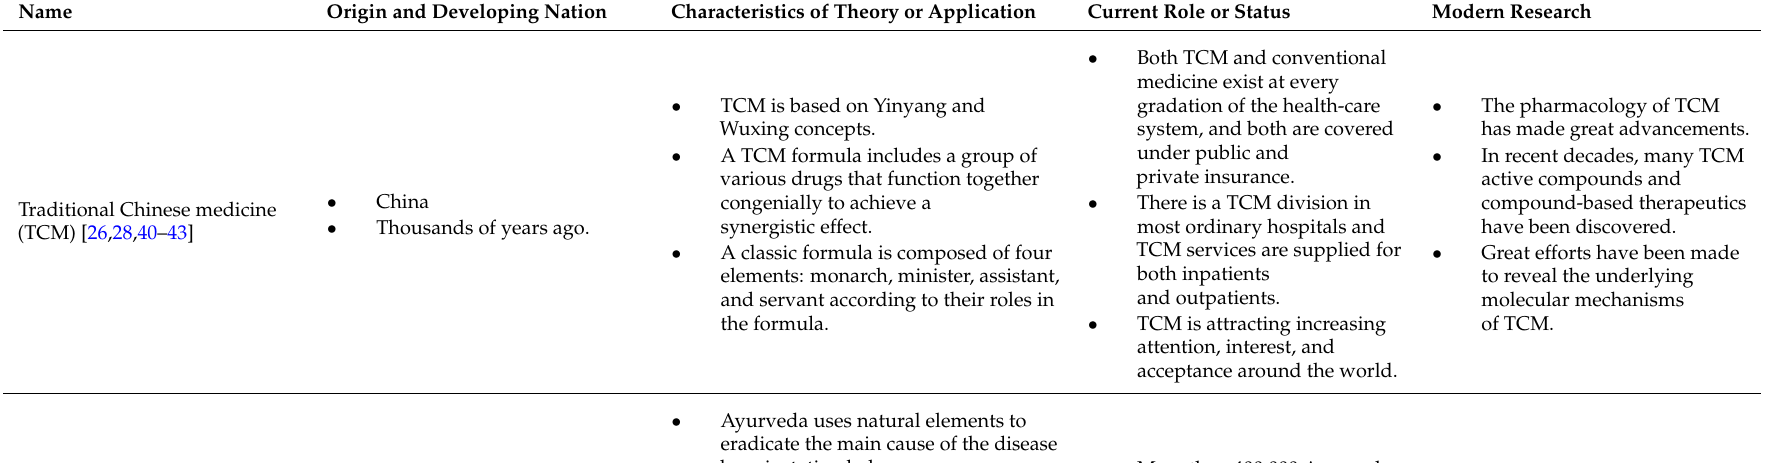
Table 1. Characteristics of several important traditional medicine